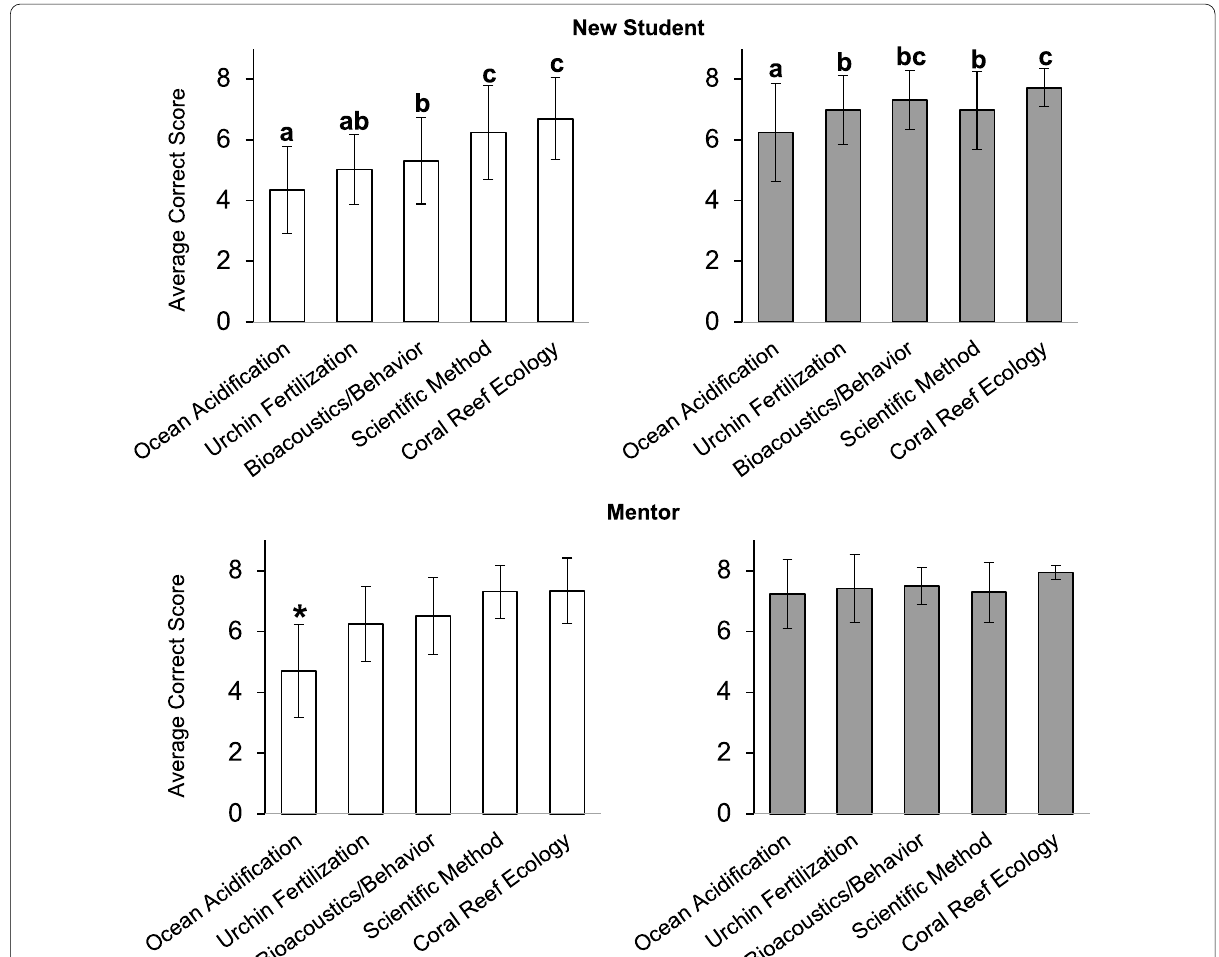
Fig. 6 Performance: Comparing iClicker Quiz scores among modules. Average correct responses on 8-question iClicker content quizzes, collected from (top) New Students ( N 54) and (bottom) Mentors ( N 18) during the 2016–2018 REMS programs. Differences between modules were = = compared with an ANOVA and post hoc Tukey tests. Letters not in common above New Student average score bars indicate significant differences between modules. For example, in the New Student pre-program data, Ocean Acidification scores (group “a”) were significantly different from Bioacoustics/Behavior scores (group “b”). Ocean Acidification scores (group “a”) were not significantly different from Urchin Fertilization scores (group “ab”). * p <